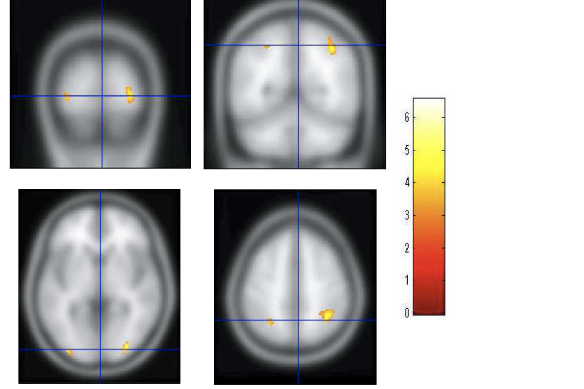
FIGURE 4 | Functional magnetic resonance imaging activation. (Upper) fMRI activities under both the green/blue, and white/gray, conditions.The bilateral parietal and occipital areas were activated under both the green/blue and white/gray conditions ( P < 0.001, uncorrected). (Lower) More significant activation in the parietal and occipital cortices (right > left) was evident under